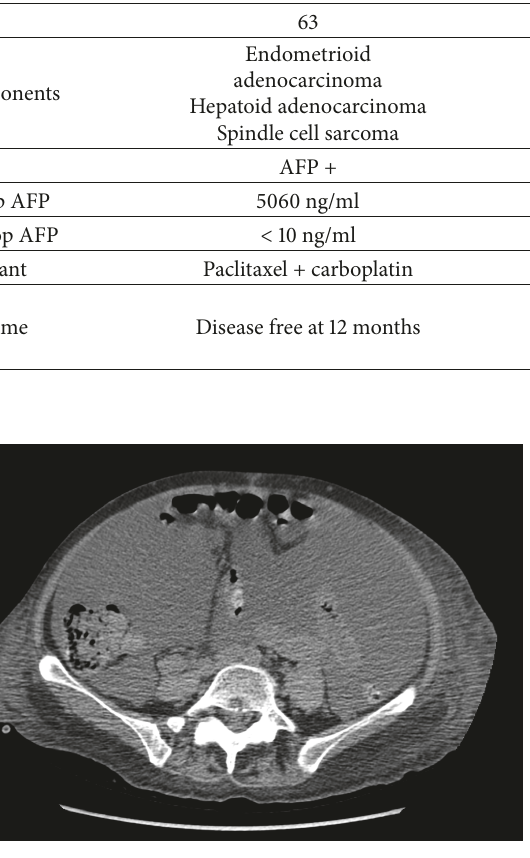
Figure 6: Liver metastasis (CT abdomen and pelvis, noncontrast